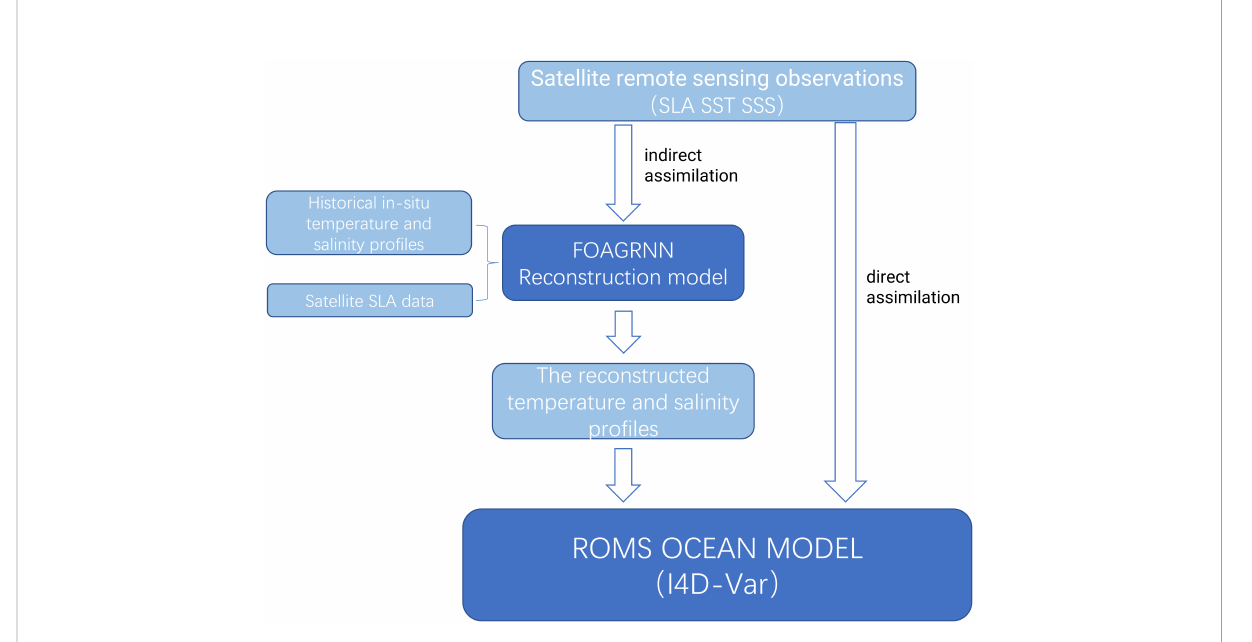
FIGURE 1 The fl ow chart of the machine learning-based assimilation